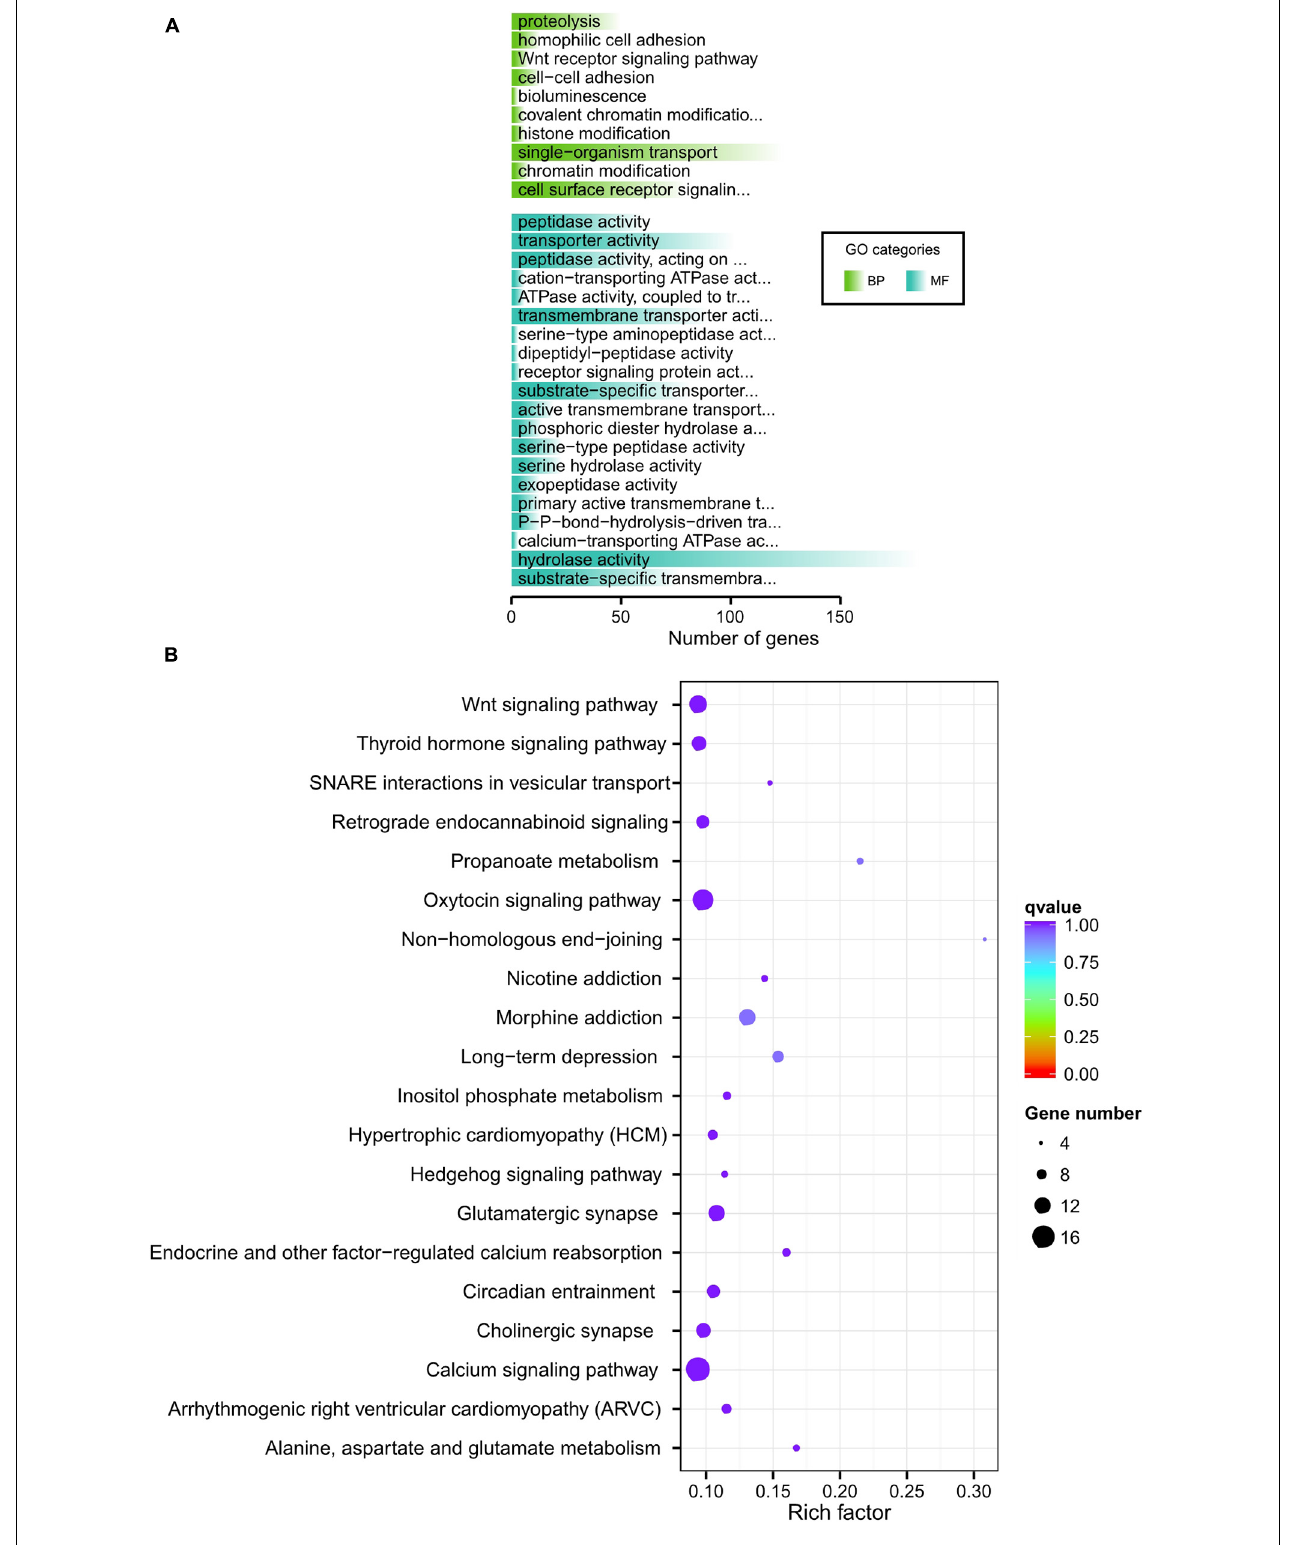
FIGURE 5 | GO and KEGG analysis of